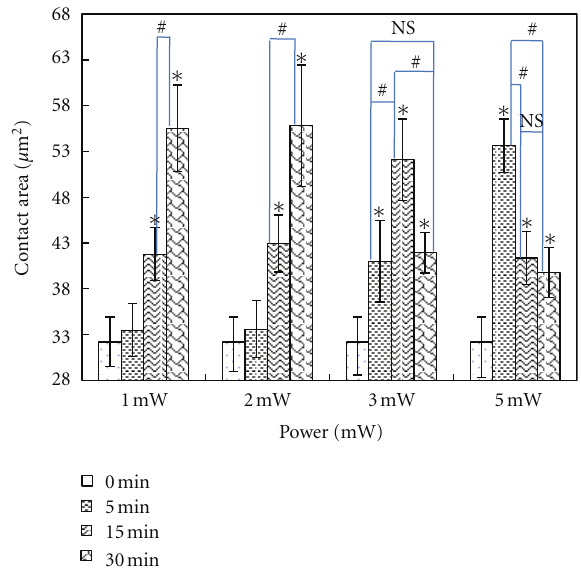
Figure 1: E ff ects of laser irradiation on the contact area of dehydrated erythrocytes. Data are means ± SD. N = 100. ∗ P < 0 . 05 versus the no irradiation group as control, # indicate significant di ff erences between the two groups, # P < 0 . 05, and NS indicate no significant di ff erences between the two groups.